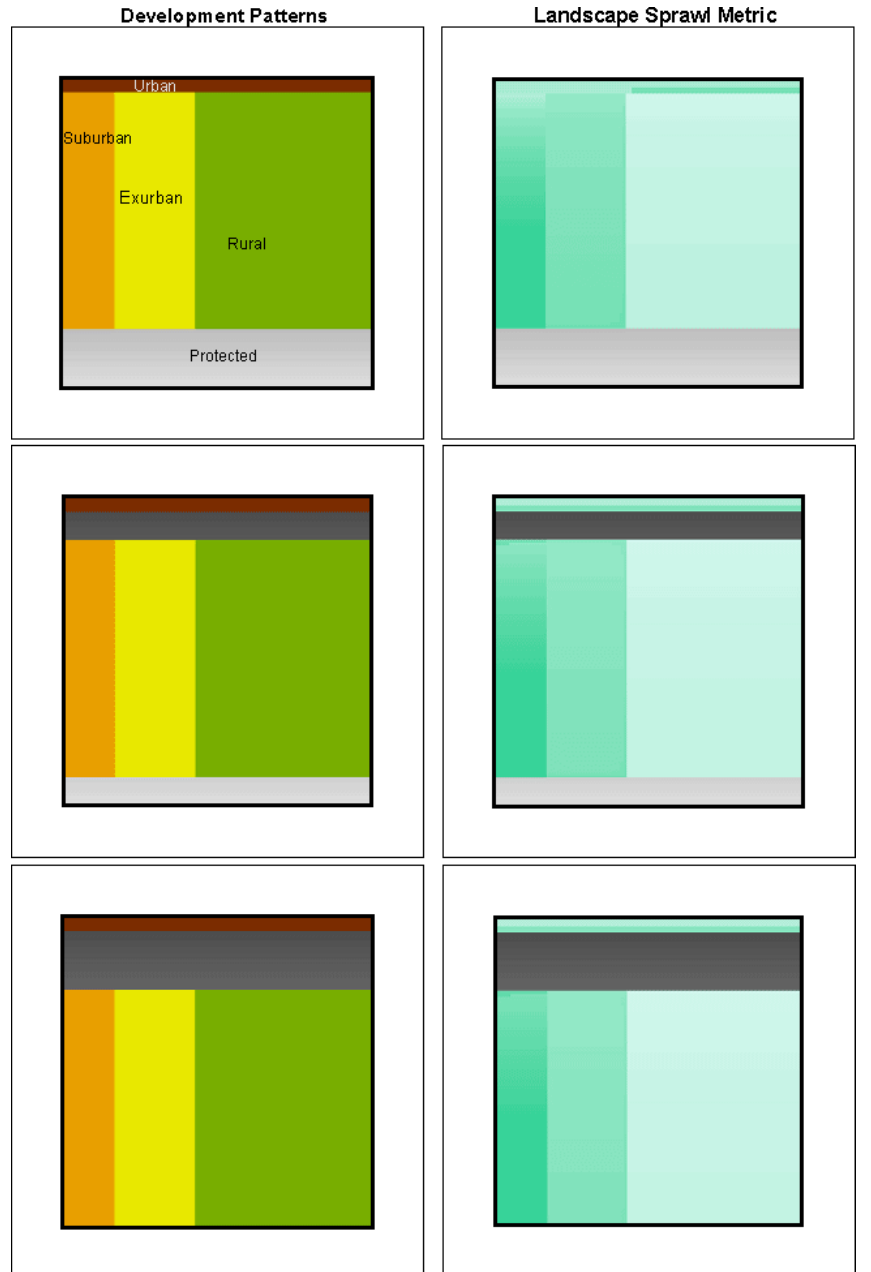
Fig. 4. The landscape metric also captures &#8220leapfrog” development and development at further distances—note that the scenarios presented here have the same areal proportions as Fig. 3 (and therefore, the same number of housing units). Compared with a fairly compact pattern (top, and also center Fig. 3), the effect of disjunct development is an increase from 338.9 (top) to 373.9 (center). Moving development yet further afield, the score increases to 399.3